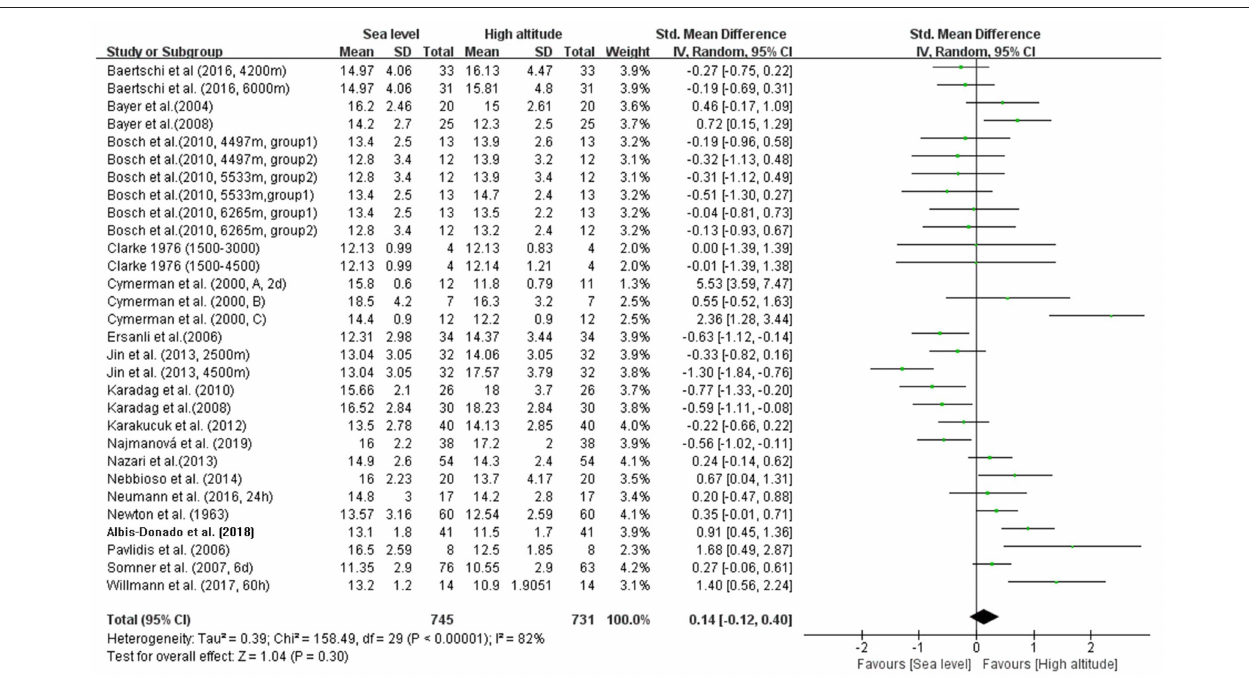
FIGURE 2 | Forest plot for the meta-analysis of the effects of high-altitude exposure on IOP for healthy lowlanders. CI, confidence interval; df, degrees of freedom; G, group; IV, inverse variance; SD, standard deviation.